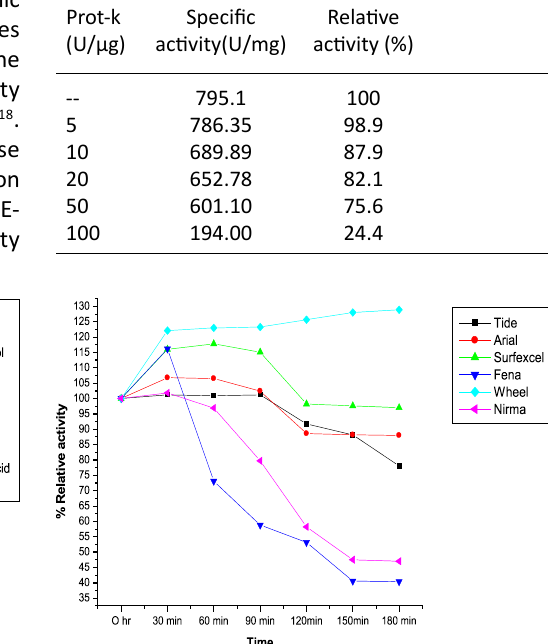
Fig. 7. Detergent compatibility test of LKE-021 Esterase on solid